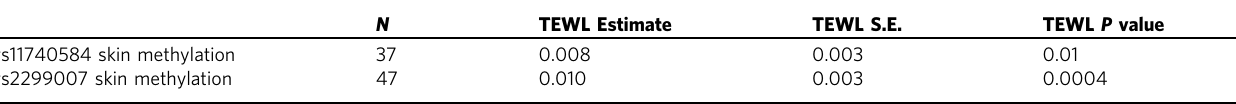
Table 2 KIF3A SNPs rs11740584 and rs2299007 methylation levels are associated with higher transepidermal water loss